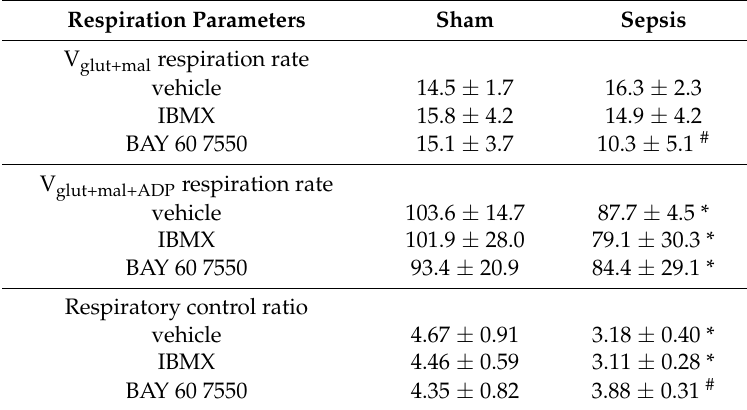
Table 1. Effects of phosphodiesterase inhibitors on mitochondrial respiration in permeabilized cardiac fiber preparations.